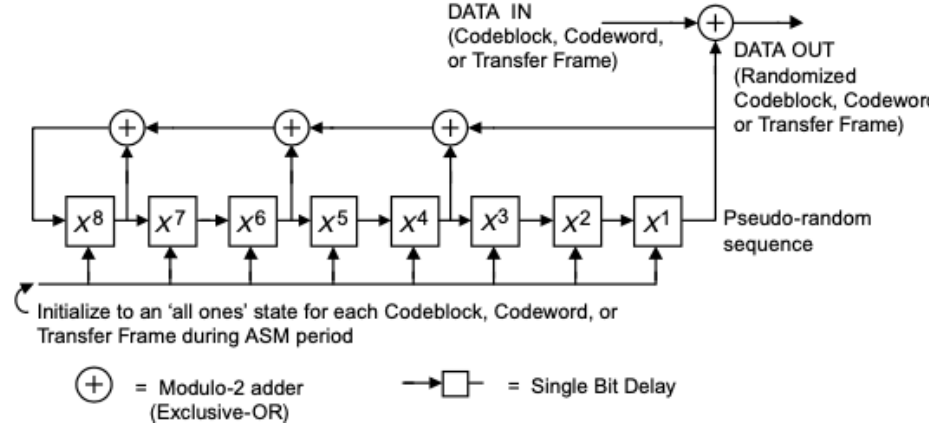
Figure 2. Pseudo-randomizer